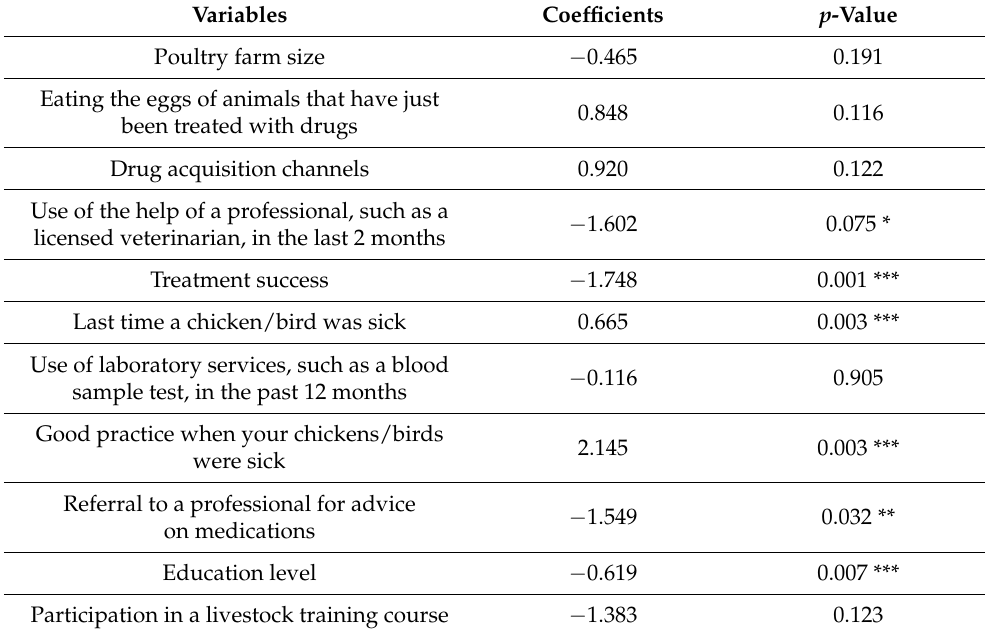
Table 5. Logistic regression results for the multivariate